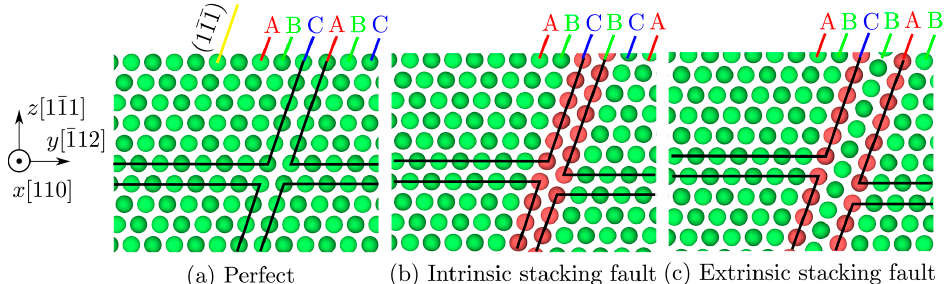
Figure 2. Atomic configurations of ( a ) a perfect lattice, ( b ) a lattice containing an ISF, and ( c ) a lattice containing an ESF. Colored by the adaptive common neighbor analysis (a-CNA) [17], green and red atoms have an FCC and hexagonal close-packed (HCP) local structures, respectively. Black lines illustrate boundaries of elements, within which there are no lattice defects. Different (11(cid:3364)1(cid:3364)) atomic planes that have the same configuration are labelled as A, B, and C, respectively. In ( a , b ), elements are employed immediately adjacent to each other; in ( c ), one layer of atoms on a between elements to accommodate the ESF, which involves three adjacent atomic